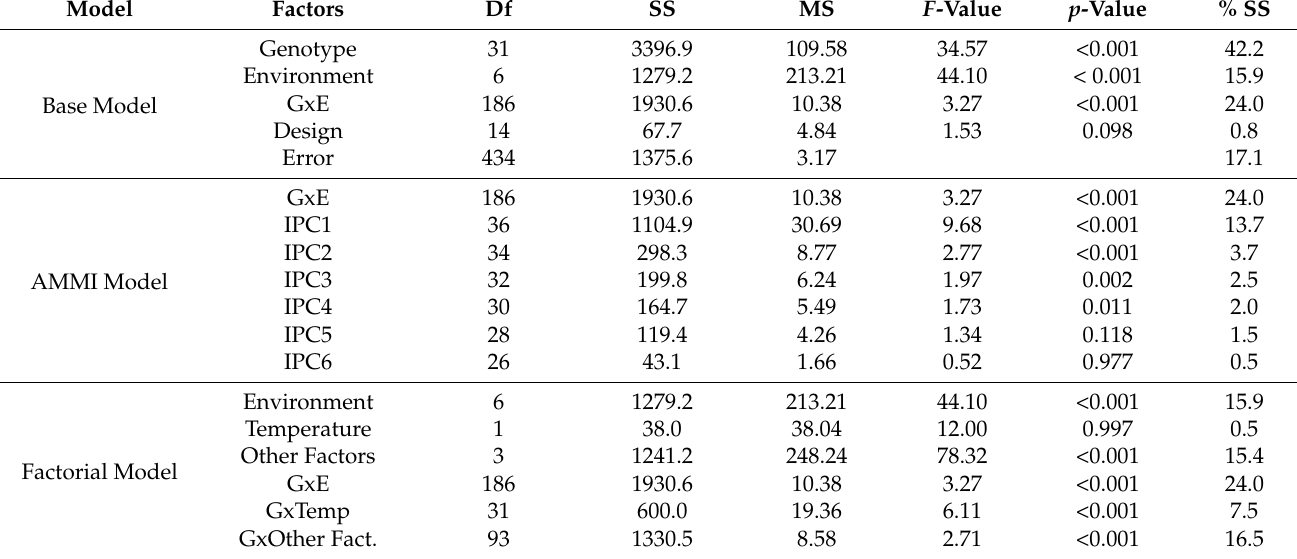
Table 3. Analysis of variance for the thousand kernel weight using the base model, the AMMI model and the factorial model. With degrees of freedom (Df), sums of squares (SS), mean square (MS), the F-value, p -value and the proportion of SS associated with each factor over the total SS